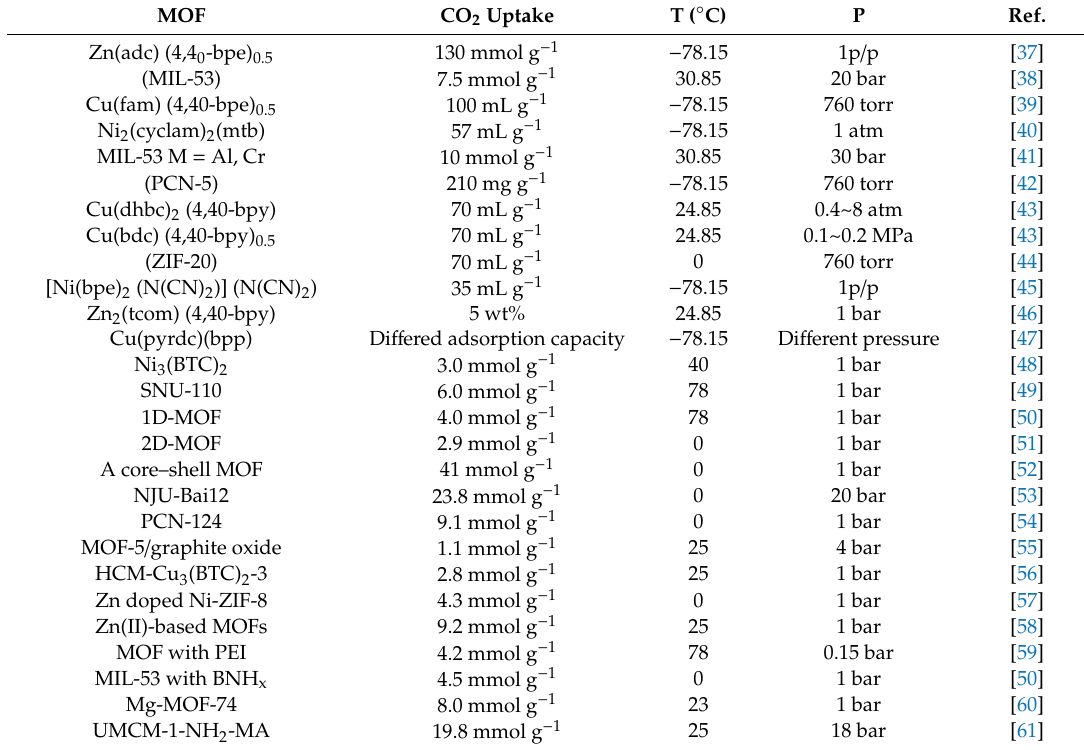
Table 6. Summary of MOF-based materials CO 2